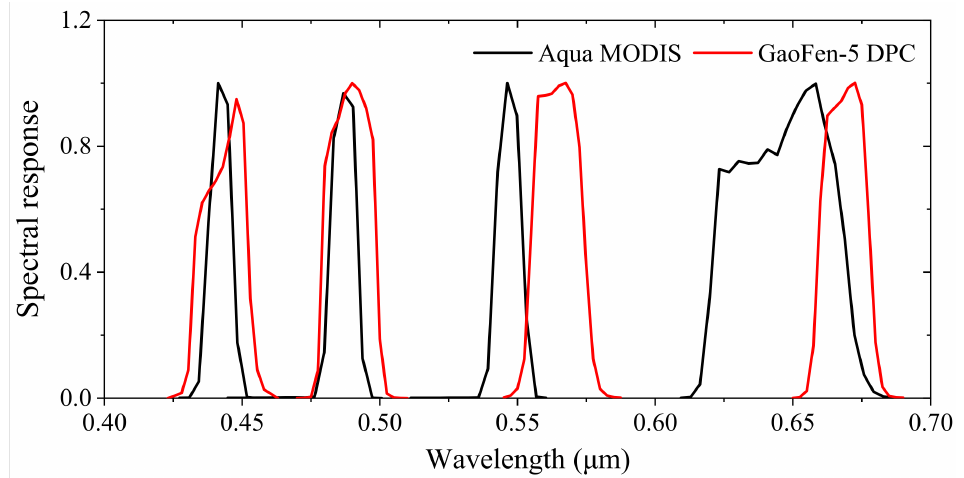
Figure 9. Comparison of the Spectral Response Function of the MODIS/Aqua and DPC/GaoFen-5 at several visible bands. Table 4. Sample selecting principle for cross-calibration of DPC/GaoFen-5 via MODIS/Aqua.